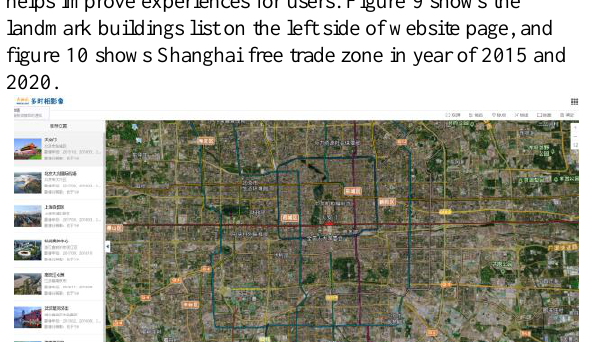
Figure 11 Multi-temporal image has covered